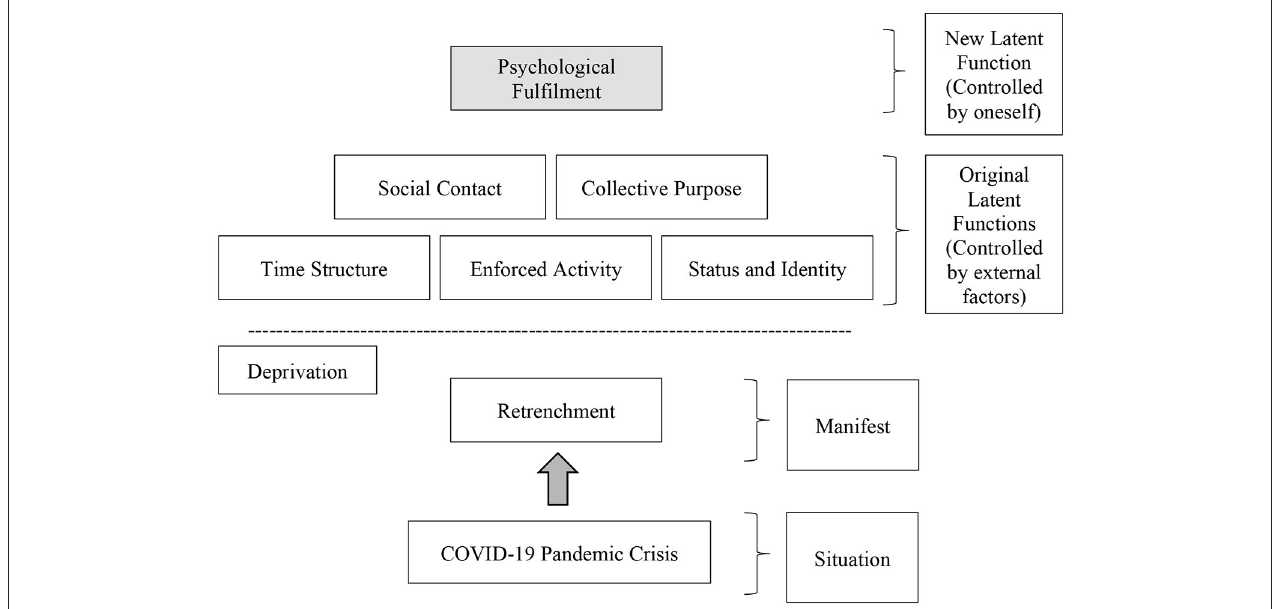
FIGURE 4 | Proposed latent-deprivation model of retrenchment under COVID-19 pandemic